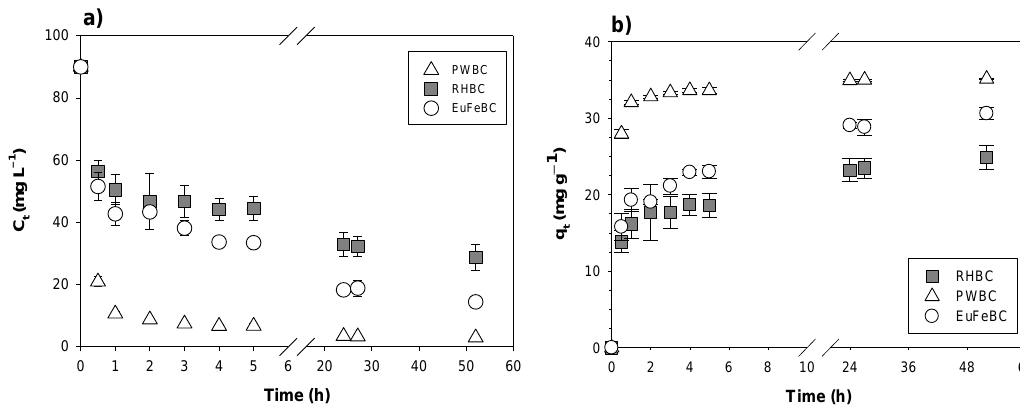
Figure 4. Kinetic results of TCE onto BCs. TCE Concentration ( a ) and TCE adsorbed per gram of BC ( b ) as a function of time. Error bars indicate the standard deviation. Table 2. Kinetic parameters for TCE on tested BCs.